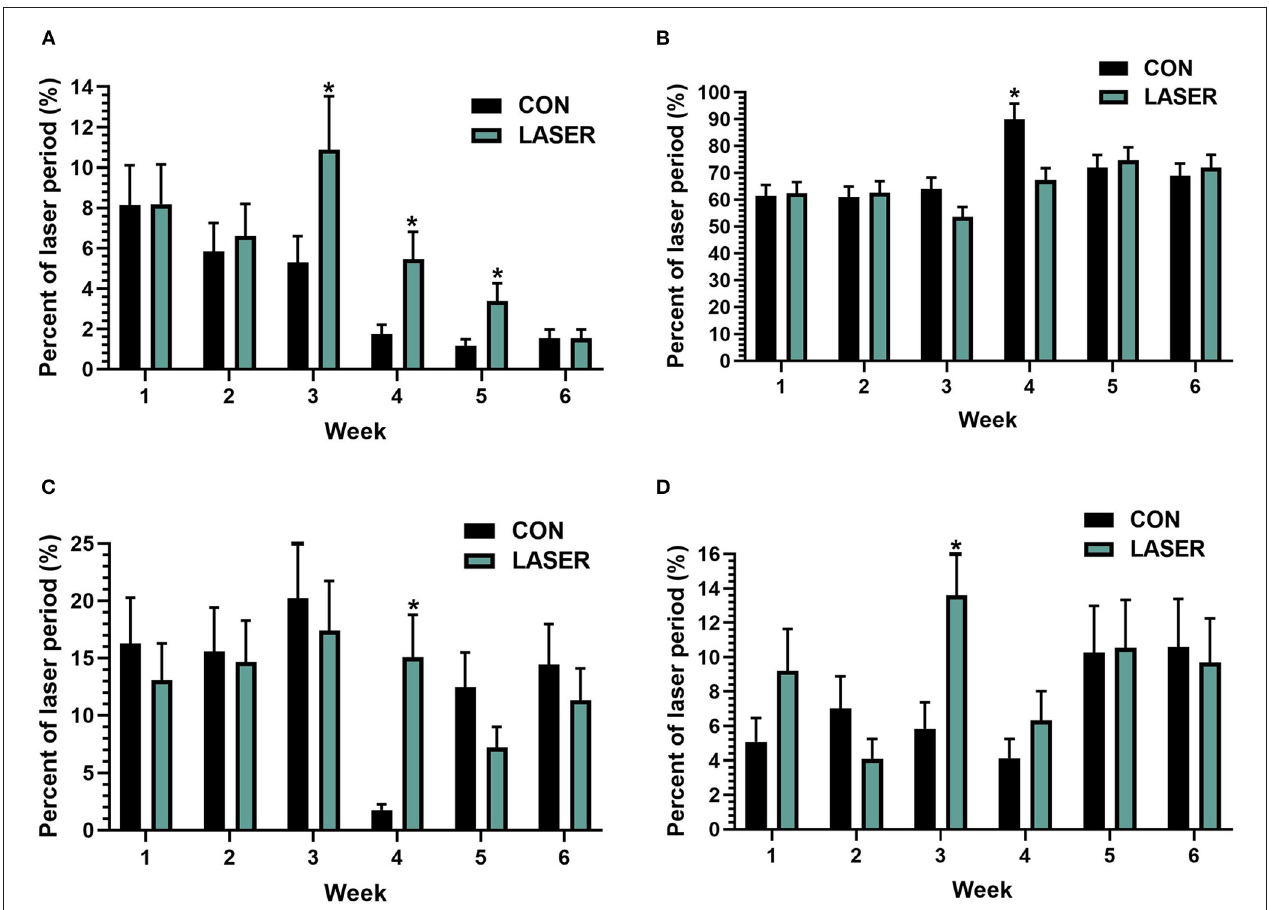
FIGURE 2 | (A–D) Ross 708 focal broiler home pen behavior over wk 1–6 during 4-min laser periods. Enrichment × week LSMeans ( ± SEM) a showing percent of time spent: (A) active; (B) inactive; (C) at feeder; and (D) at drinker. The same day each week was used for video recording. a Bars denoted * indicate means that are significantly different within the same day/week ( P ≤ 0.05).